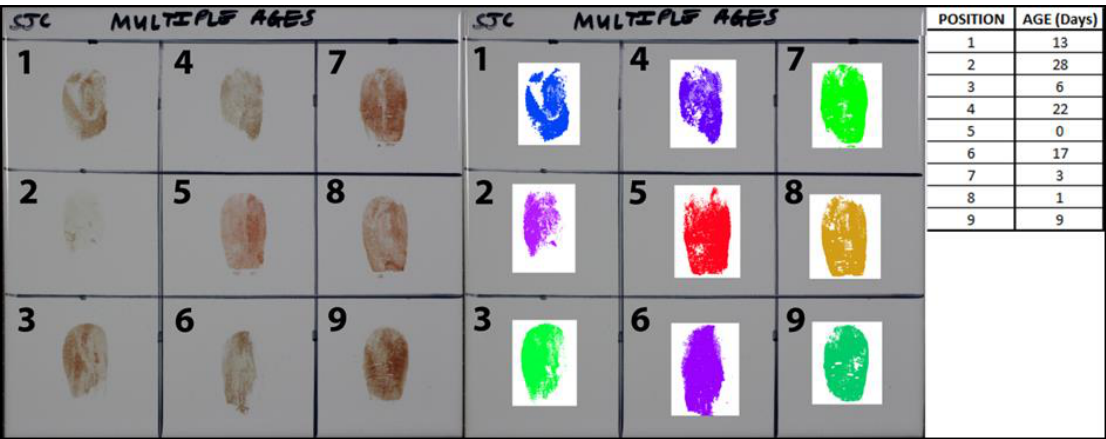
Figure 9. Digital single lens reflex (DSLR) ( left ) and false colour images manually coloured from HSI analysis ( right ) of blood-stained fingerprints based on a 30-day false colour scale.